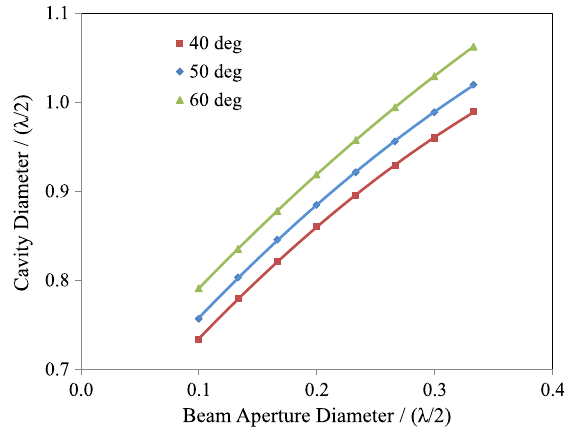
FIG. 35. Electric field and magnetic field contribution to the transverse deflection of the rf-dipole cavity designs with the varying beam